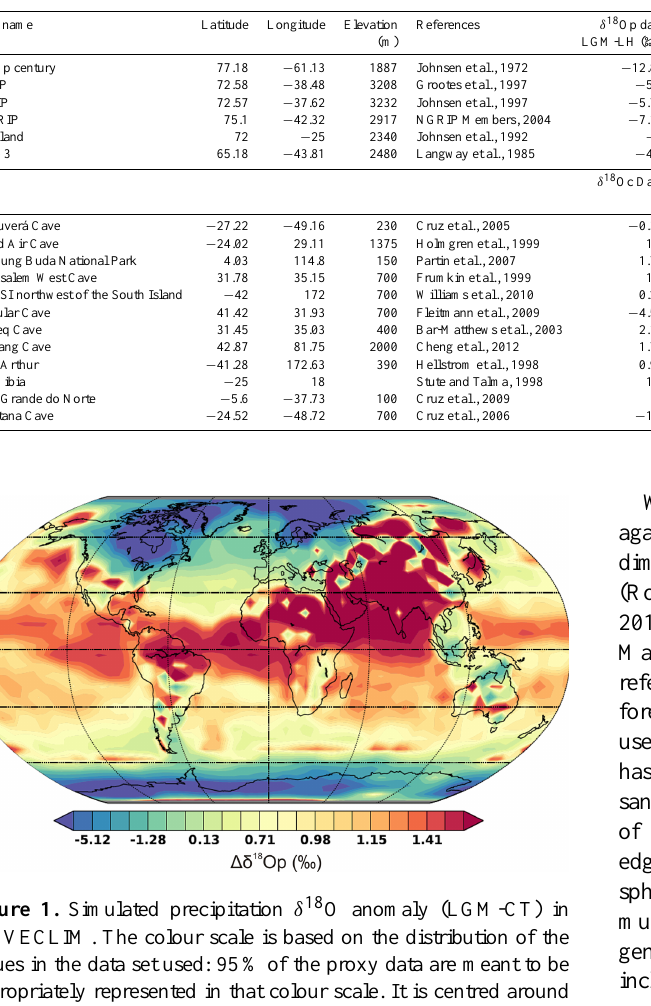
Table 1. δ 18 O anomaly between the LGM and LH compiled for Greenland ice cores and speleothem records and compared to model ( i LOVECLIM) results.